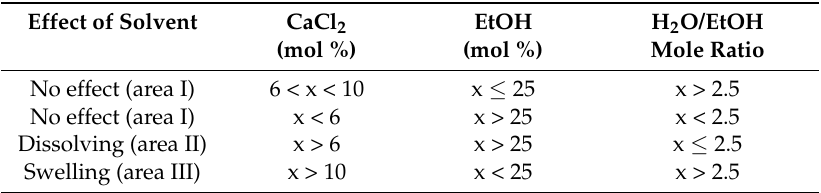
Table 2. Description of the areas assigned to the three different